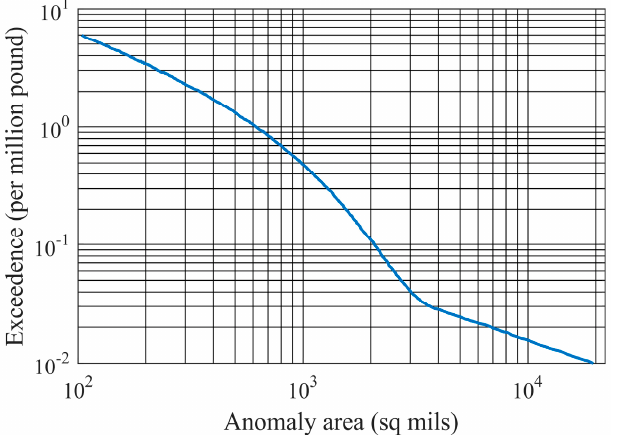
Figure 7. Initial anomaly distribution.